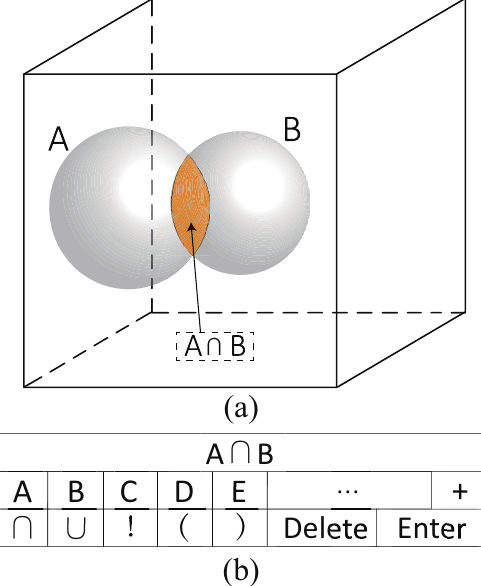
Figure 5. ( a ) Query the intersection of quadric A and B. ( b ) The virtual keyboard not only has five surfaces A–E, but also includes the Add button (used to add a new quadric surface), the intersection symbol (used to perform a specific set operation on the surface set), the delete key and the enter key (used to perform quadric surface queries) of set operation expression. In the immersive environment, users can click the virtual keyboard through the handle, input a specific set operation expression, and query the UFP in the corresponding quadric